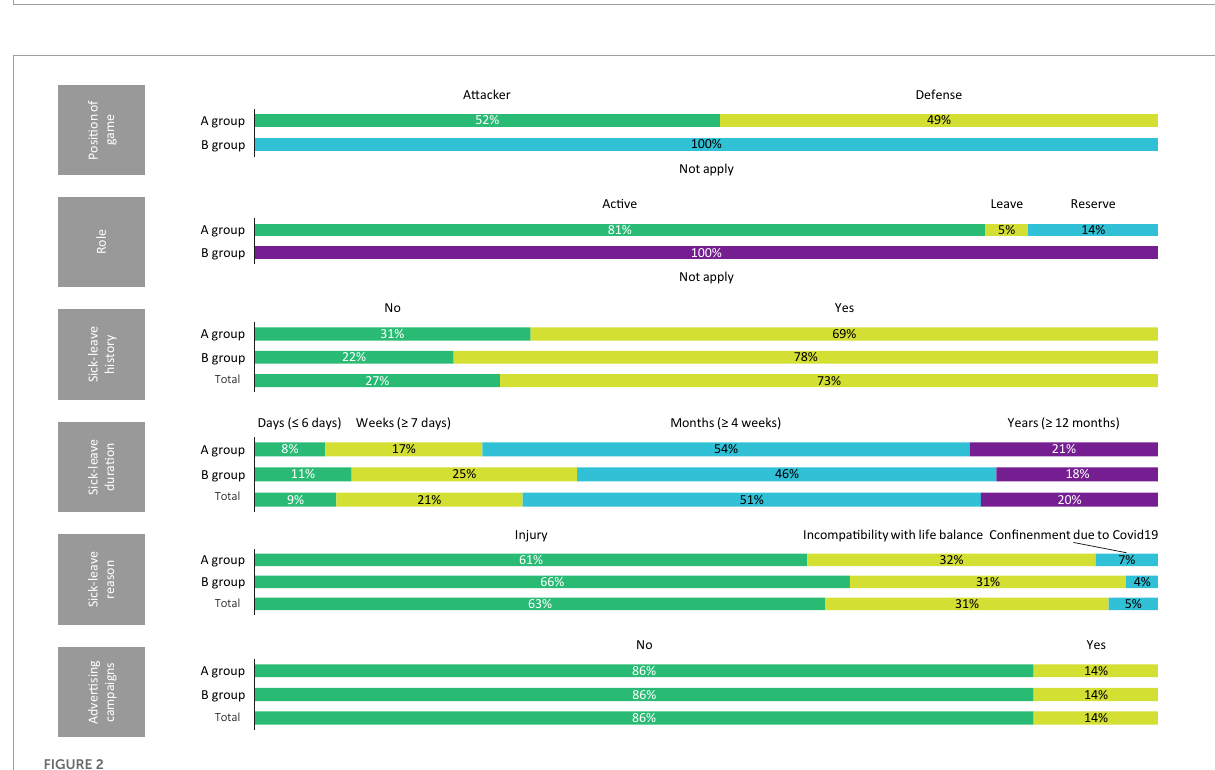
FIGURE2 Distribution of the sample according to the position of game, role, sick-leave history, sick-leave duration, sick-leave reason, and participation in advertising